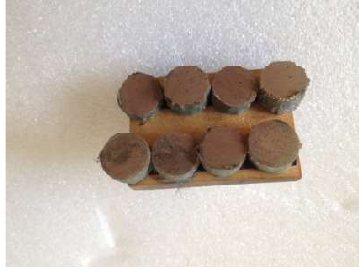
Figure 4. SEM sample preparation.